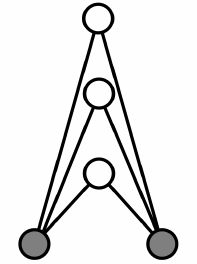
Figure 2. A graph exhibiting shared partners’